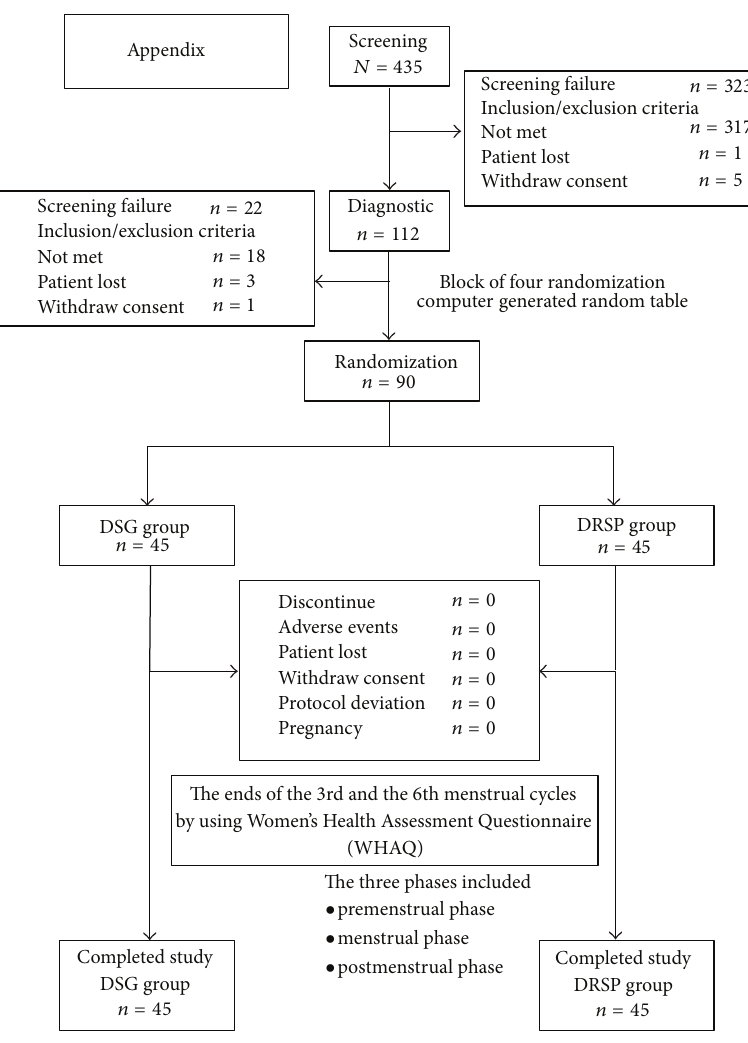
Figure 1: Participation flow. DSG group used the preparation of ethinyl estradiol 20 𝜇 g/desogestrel 150 𝜇 g, and DRSP group used the preparation of ethinyl estradiol 20 𝜇 g/drospirenone